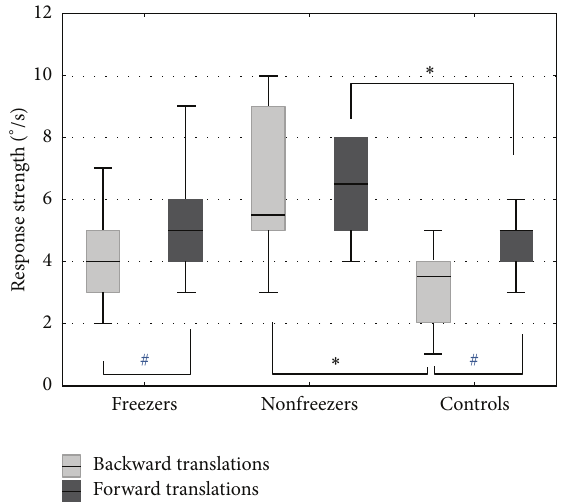
Figure 2: Group differences in MCT performance. Response strength of the left leg in forward and backward translations during MCT (pooled for small, medium, and large conditions). Boxes represent median values and interquartile ranges (Q25–Q75) with error bars indicating the nonoutlier range. ∗ Significant difference ( 𝑃 < 0.05 ) between two groups (post hoc), # significant difference ( 𝑃 < 0.05 ) within groups.